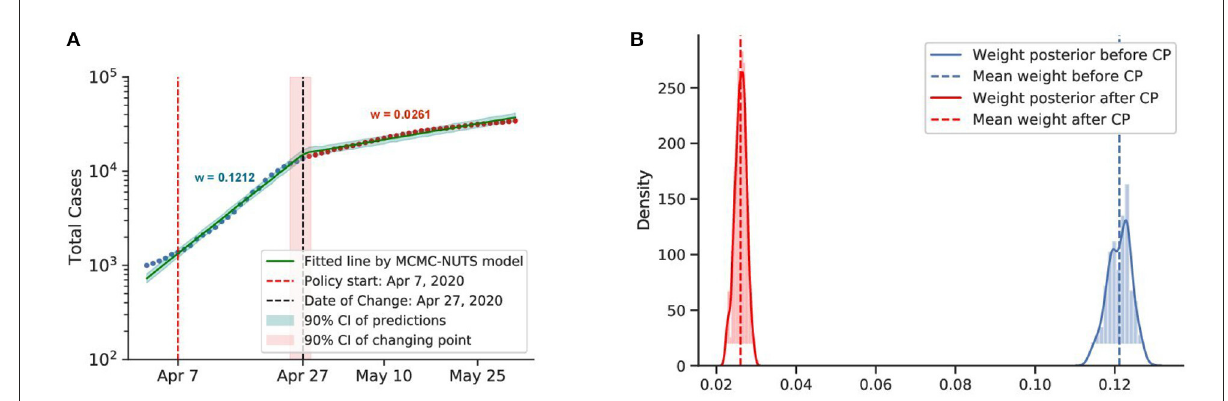
FIGURE8 Posterior for Singapore. Singapore saw a rapid growth of the caseload among migrant workers around April 2020, and a “circuit-breaker” was imposed on April 7 (73) that brought the outbreak under control in late April, with the growth rate declining from 0.1212 to 0.0261. The change-point point was around April 27, 2020. (A) Fitted graph for Singapore with change-point on April 27, 2020. (B) Posterior distribution of weights (transmission rate) before and after change-point.